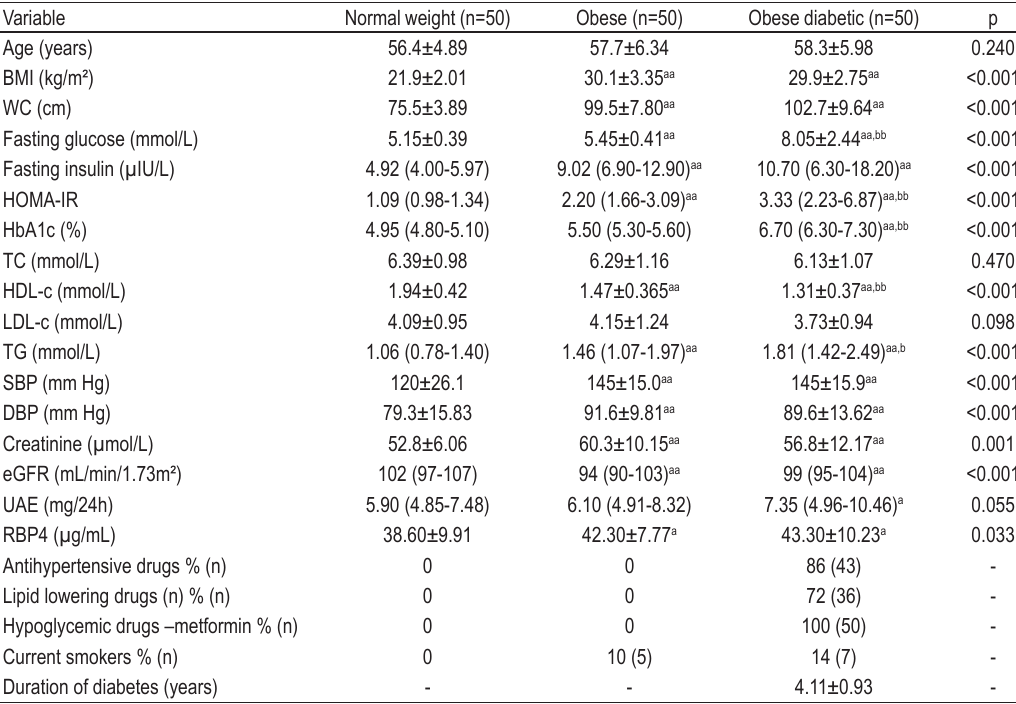
TABLE 1. Demographic and general characteristics of studied women Variable Normal weight